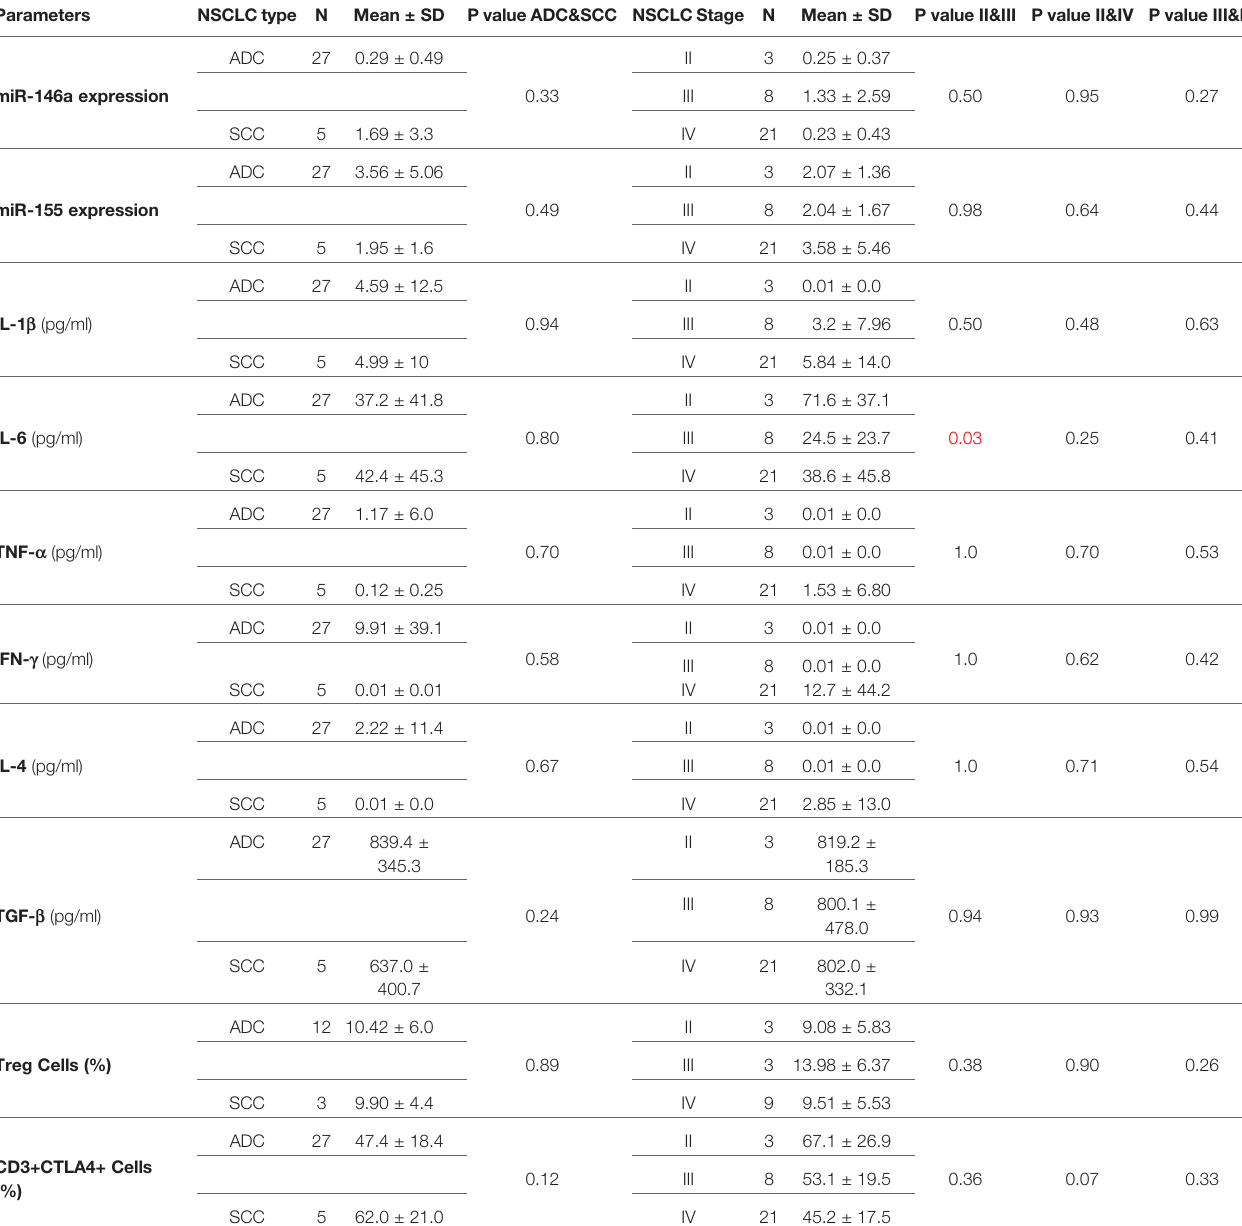
TABLE 5 | Data analysis on correlation of NSCLC patients with type and stages of diseases with studied parameters.